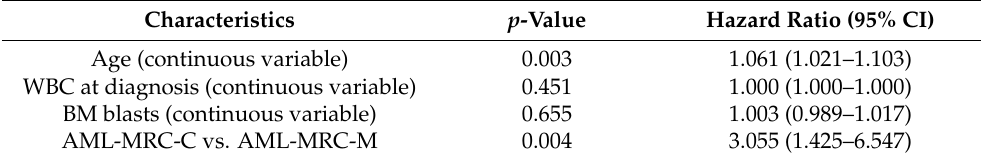
Table 3. Multivariate analysis for overall